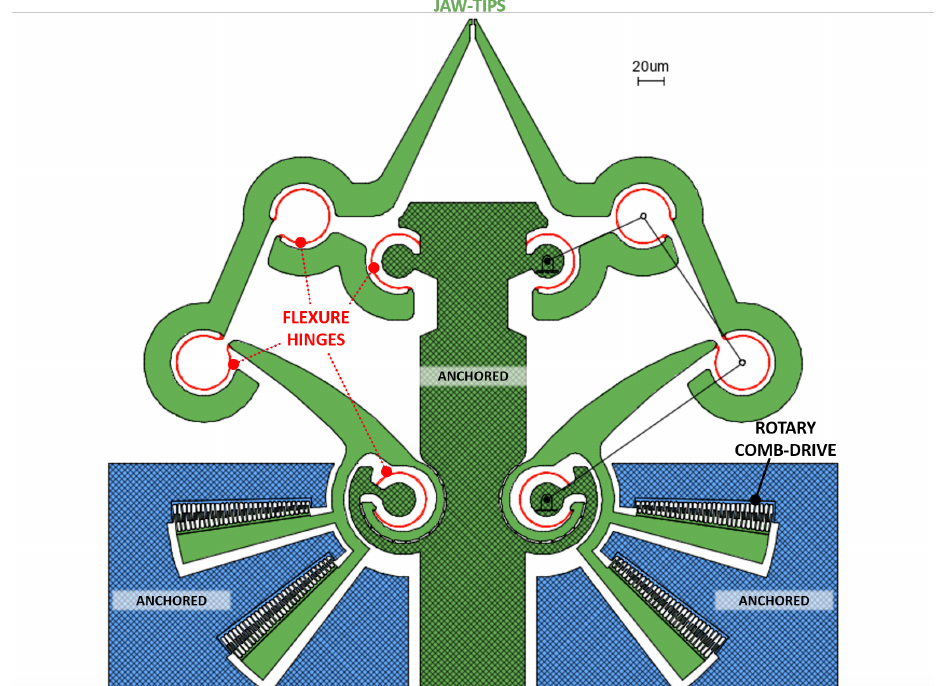
Figure 2. Front view of the designed